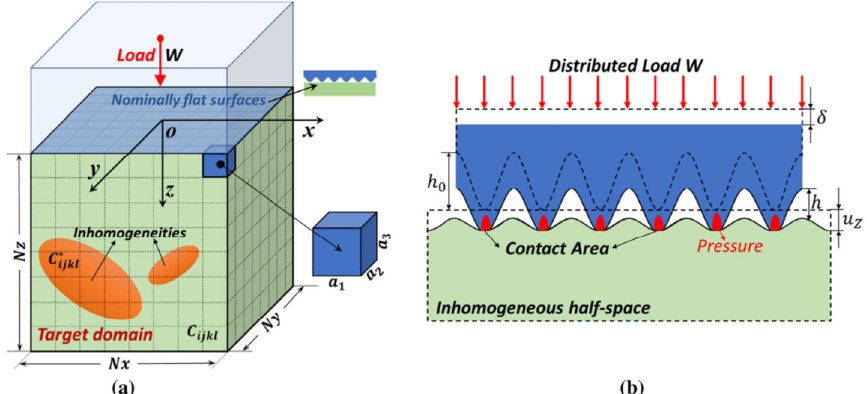
Fig. 66 A surface-contact model of inhomogeneous material subjected normal load [895]. Reproduced with permission from Ref. [895], © Springer-Verlag GmbH Germany, part of Springer Nature, 2021.